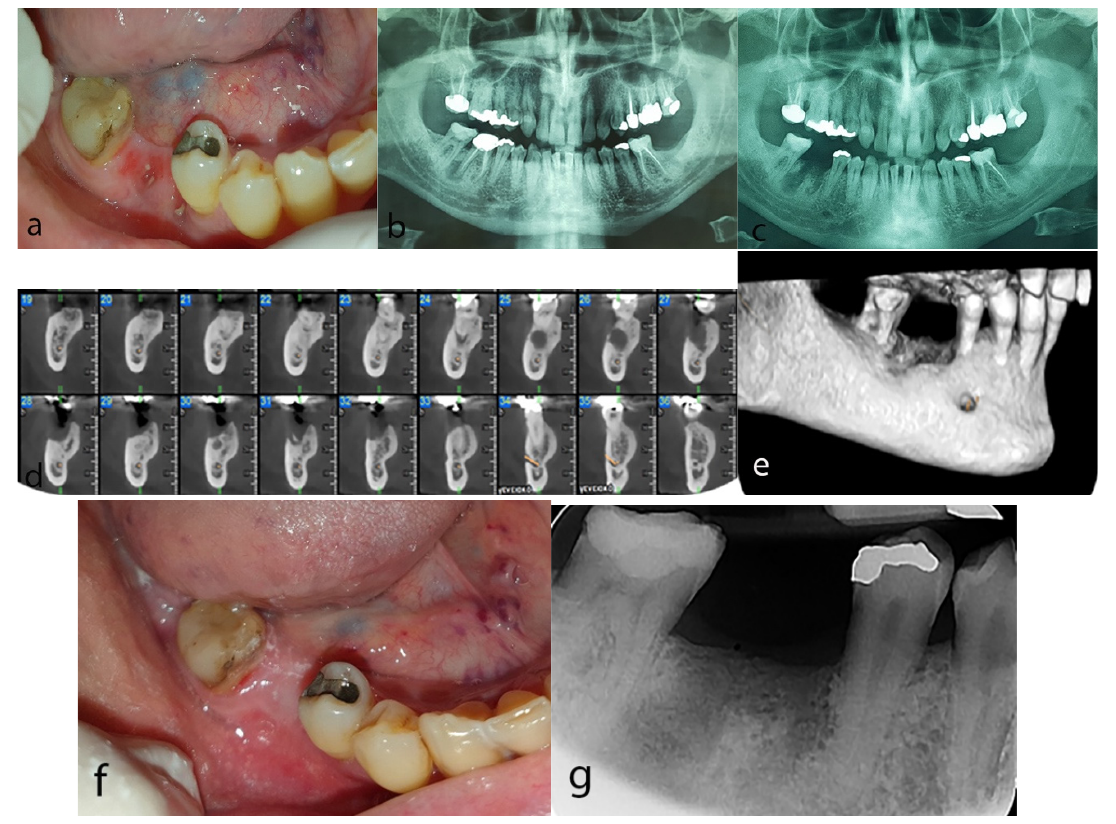
Figure 3. Case 3: ( a ) Exposed necrotic bone at the site of the extraction of the first right mandibular molar. ( b ) Panoramic radiograph before the extraction revealing radiolucent lesions around the apices of the right first mandibular molar. ( c ) Post-extraction panoramic radiograph showing phantom socket at the extraction site. ( d , e ) CBCT revealing a diffuse hypodense lesion containing a hyperdense area at the post-extraction site of the right mandible ( d ) cross sectional views, ( e ) 3D reconstruction). ( f ) Complete mucosal coverage at the post-extraction site after 4 months of conservative treatment. ( g ) Periapical radiograph demonstrating normal bone remodeling process after 4 months of conservative treatment.